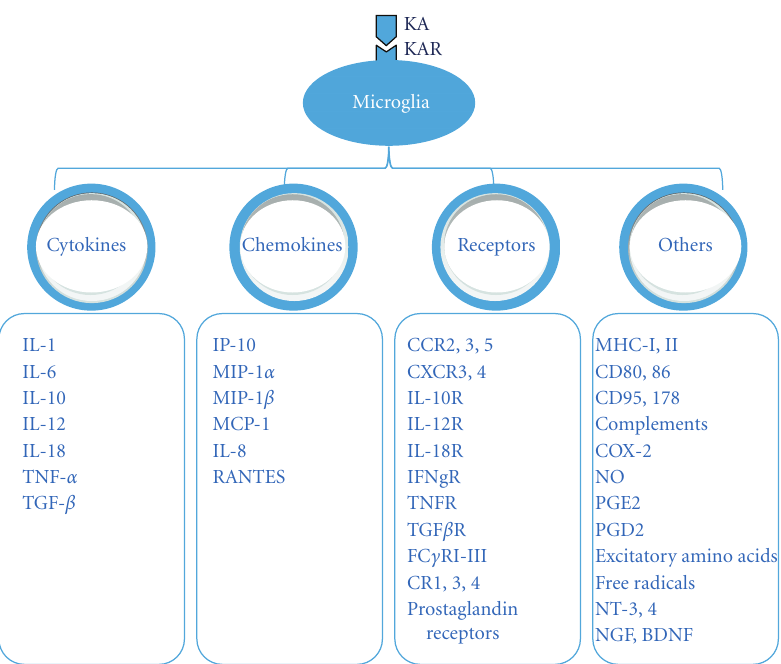
Figure 2: KA-induced microglial activation. Activated microglia express MHC class I and II, costimulatory molecules (CD80 and CD86), chemokine receptors (CCR2, 3, 5, CXCR3, 4, etc.), cytokine receptors (IL-10R, IL-12R, IL-18R, IFNgR, TNFR, TGF β R, etc.), complement receptors (FC γ RI-III and CR1, 3, 4, etc.), and prostaglandin receptors, produce complements, prostaglandins, cytokines (IL-1, IL-6, IL- 10, IL-12, IL-18, TNF- α , TGF- β , etc.), chemokines (IP-10, MIP-1 α , MIP-1 β , MCP-1, IL-8, RANTES, etc.), ROS, and RNS, and secrete neutrophins (NGF, BDNF, and NT-3, 4, etc.), proteases, and excitatory amino acids, and so forth, which may either contribute to excitotoxic damage or be protective against KA damage. IL: interleukin; CCR: C-C chemokine receptor; CXCR: CXC chemokine receptor; IFNgR: interferon gamma receptor; TNF: tumor necrosis factor; TGF: transforming growth factor; IP: Interferon gamma-inducible protein; MIP: macrophage inflammatory protein; MCP: monocyte chemotactic protein; RANTES: regulated upon activation, normal T-cell expressed and presumably secreted; NGF: nerve growth factor; BDNF: brain-derived neurotrophic factor; NT: